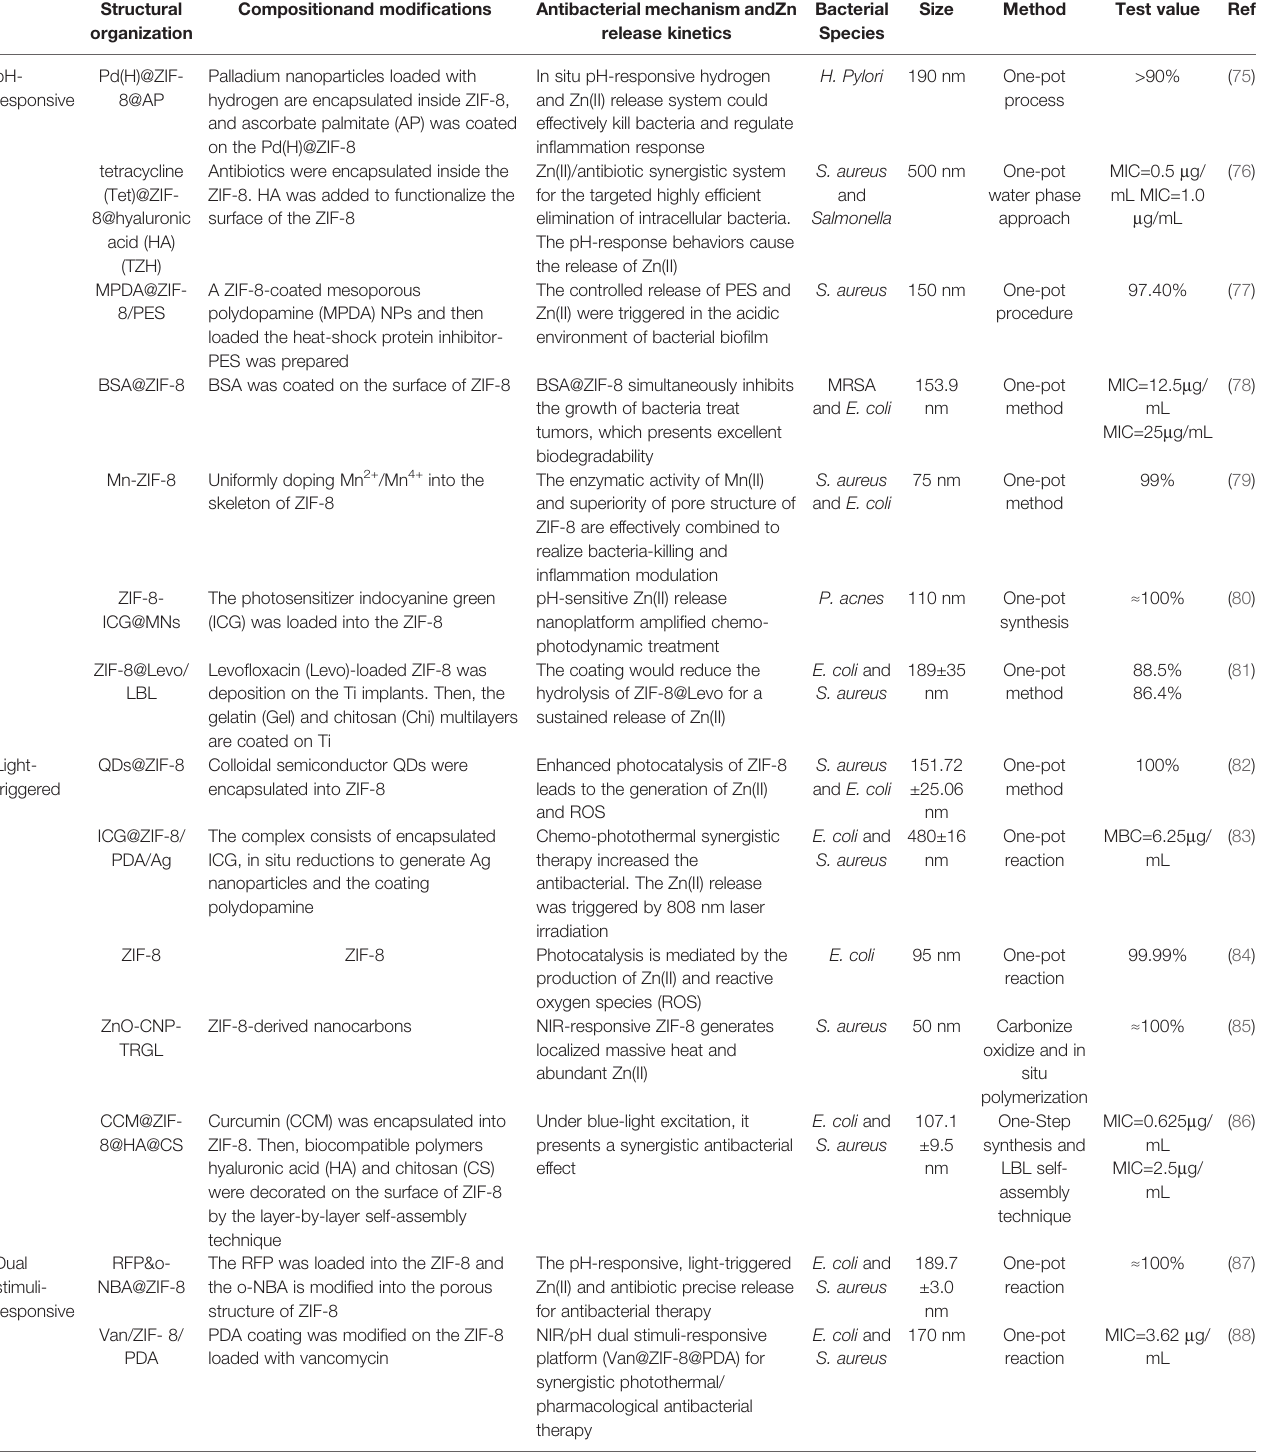
TABLE 1 | Application of antibacterial ZIF-8-based nanodelivery